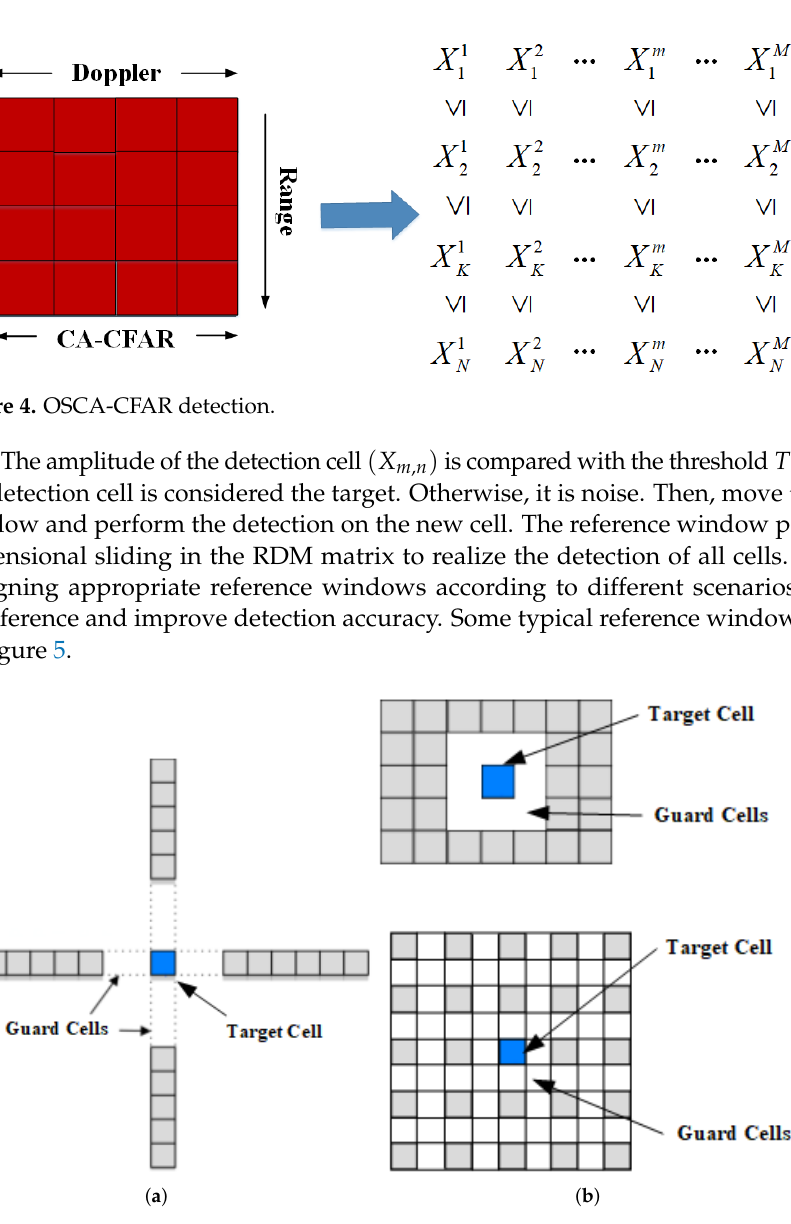
Figure 5. Typical reference window model. ( a ) Cross window. ( b ) Rectangular